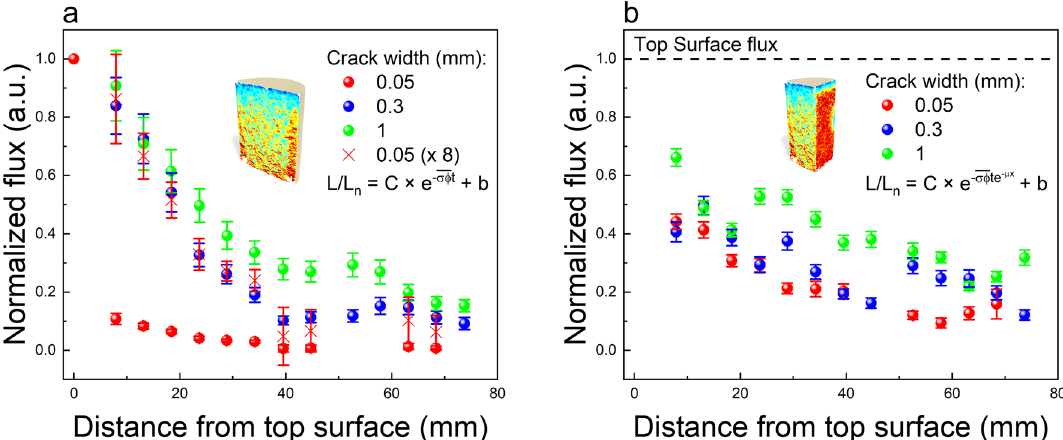
Figure 7. Dependency of light flux down cracks of various widths. Flux normalized by the decay rates at the surface for the ( a ) time-dependent and ( b ) depth-dependent